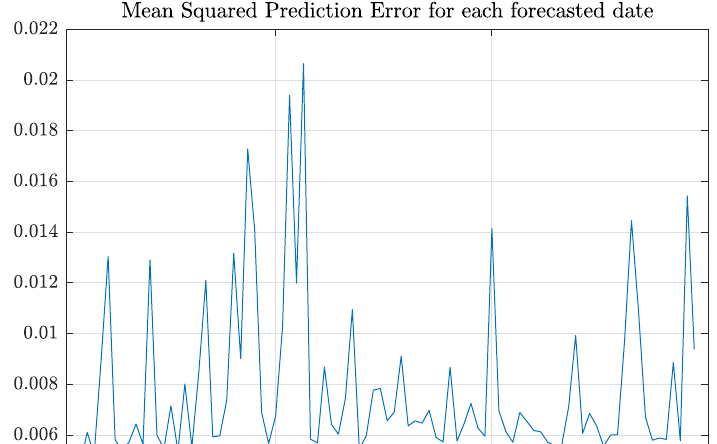
Figure 13. Panel ( a ): Monte Carlo Simulation of forecasted returns R t for the next 30 days starting at 1 June 2019. Panel ( b ): MSPE for the next three months, starting at 1 June 2019. Figure 13, panel ( b ), shows the values of MSPE t + j with t = 1-June-2019 for j = 1, . . . , 92 (the next three months). We have also considered the mean of MSPEs over the 3-month ∑ 92 forecasting horizon MSPE : = 1 t = 1 92 the lowest value MSPE = 0.0116 among all the models that we have tested, further vali- dating the choice of